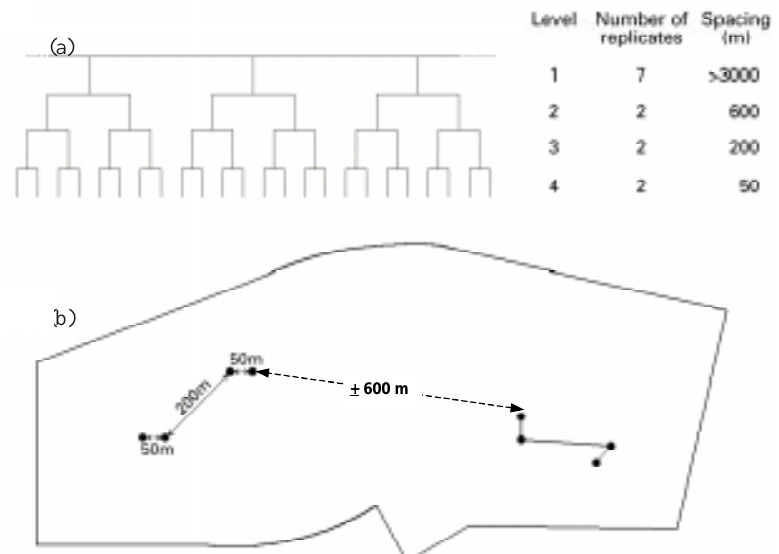
Figure 2. Layout of the nested sampling scheme in Araras and Passo Fundo. (a) Hierarchy of sampling levels; (b) Example of spatial distribution of sampling sites in one